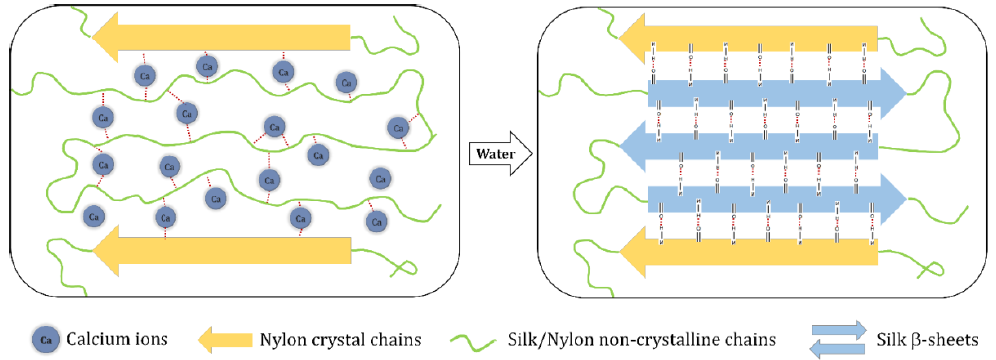
Figure 6. Proposed mechanism for silk-nylon molecular interactions induced by removing CaCl 2 in water.